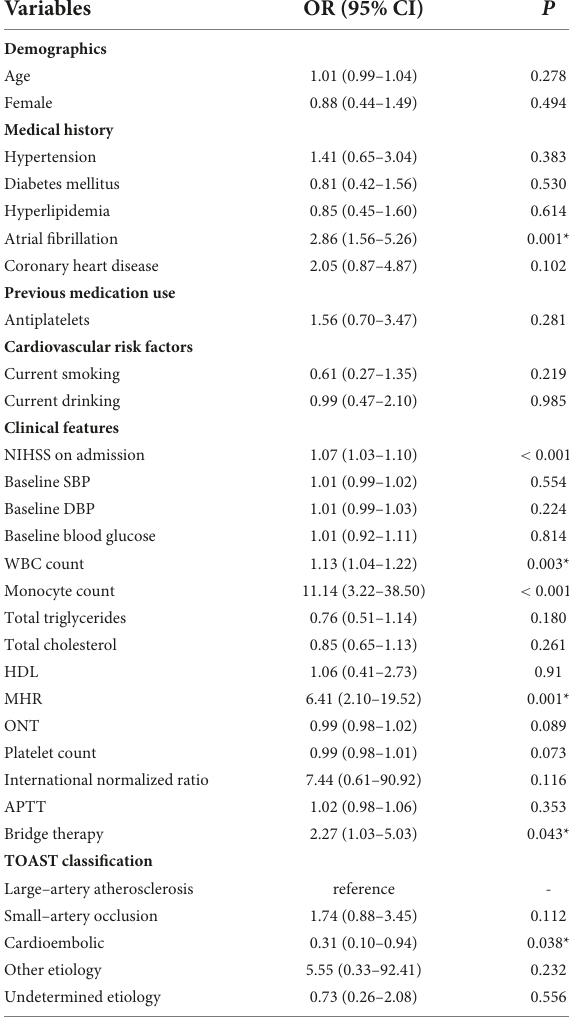
TABLE 2 Comparison of characteristics between patients who experienced hemorrhagic transformation (HT) or not. Characteristic